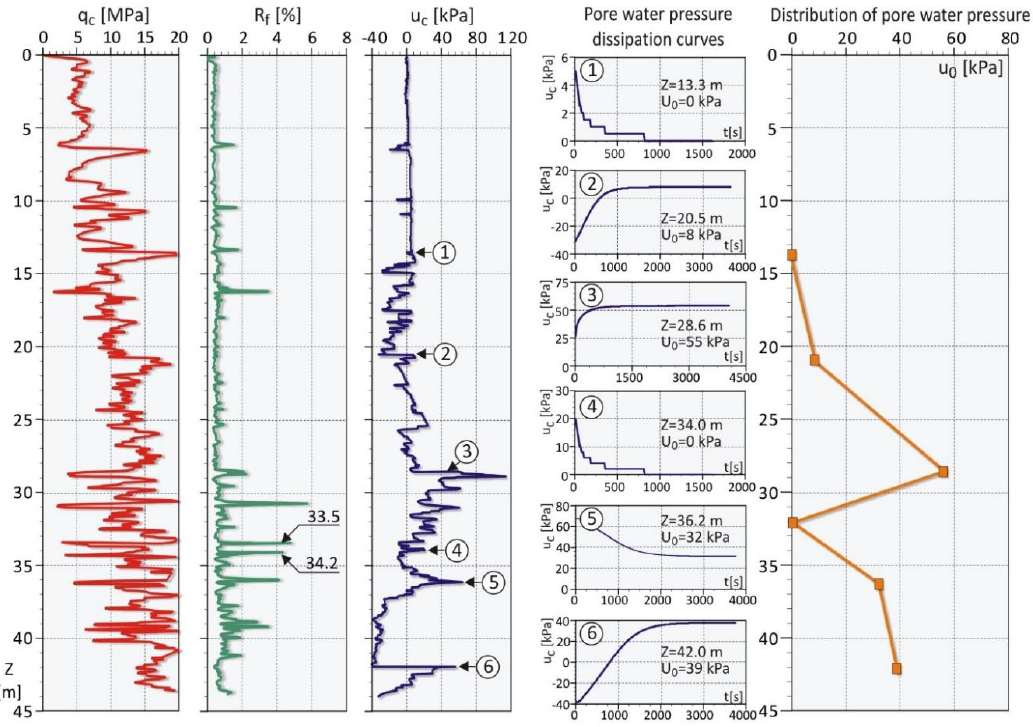
Figure 7. Identification of water conditions of sediments based on cone penetration test (CPTU) results.